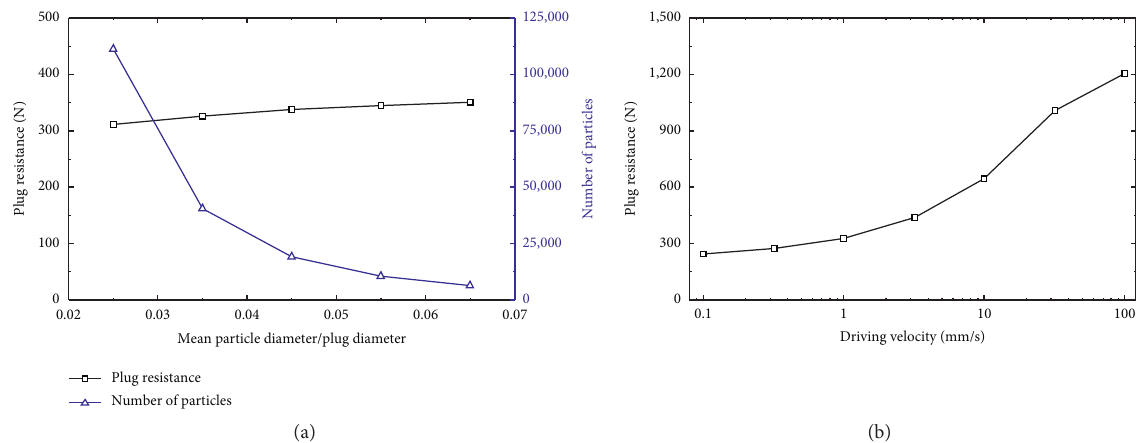
Figure 4: Sensitivity study of the soil plug model on (a) particle size and (b) wall moving velocity ( D � 10cm and L / D � 4.0).